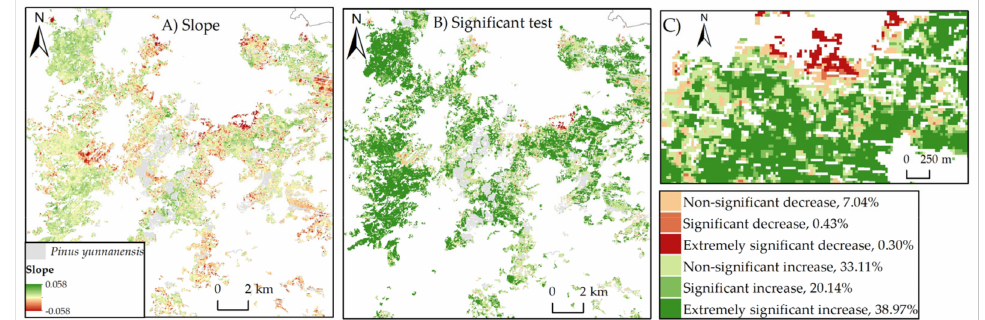
Figure 10. Slope and significance tests (2009 to 2020). ( A ) Slope; ( B ) Significant test results; ( C ) Local significance test results.